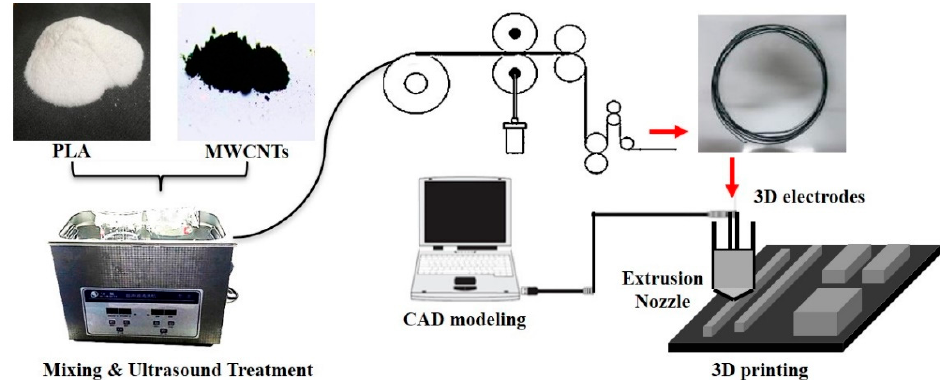
Figure 1. The fabrication process of poly lactic acid (PLA)/multi-walled carbon nanotubes (MWCNTS) composite materials by three-dimensional (3D) printing.